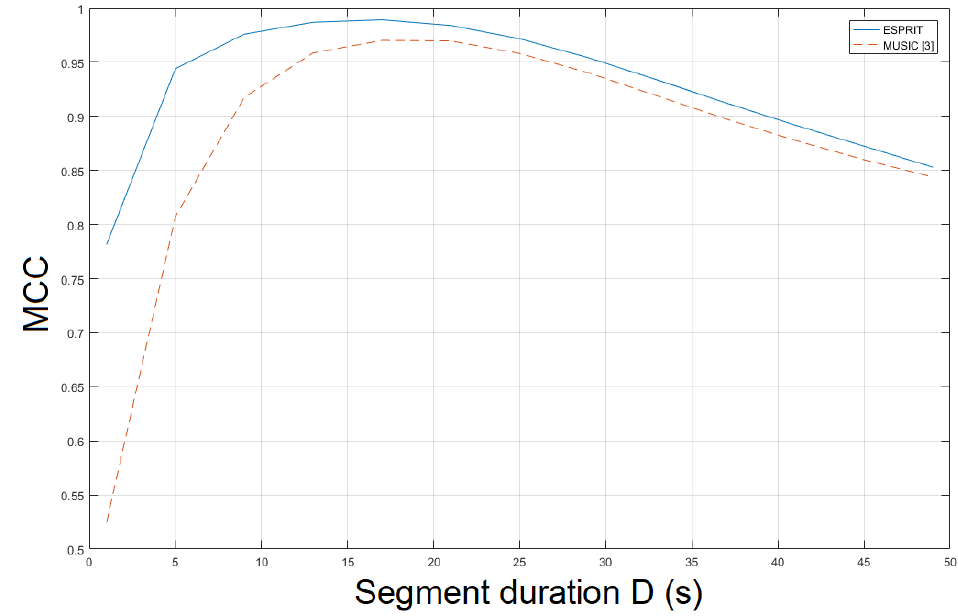
Figure 2. Maximum correlation coefficient of the proposed approach employing SLIC+ESPRIT for various segment durations against the MUSIC [3] (mov1).